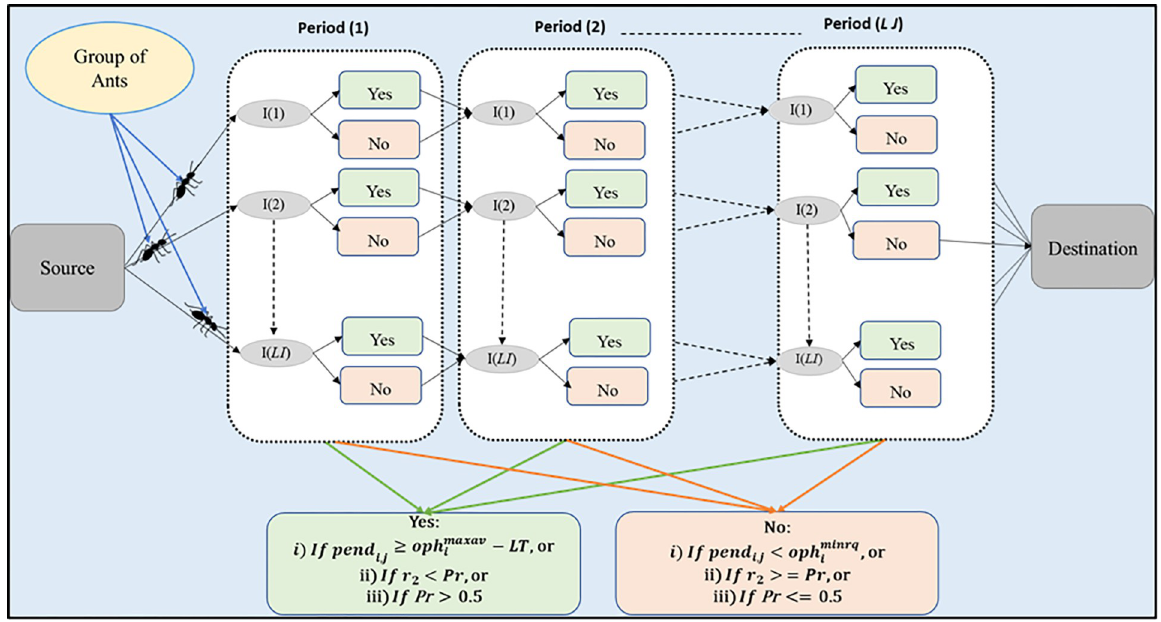
Fig 1. Graph model for maintenance scheduling of generating units using ants’ group